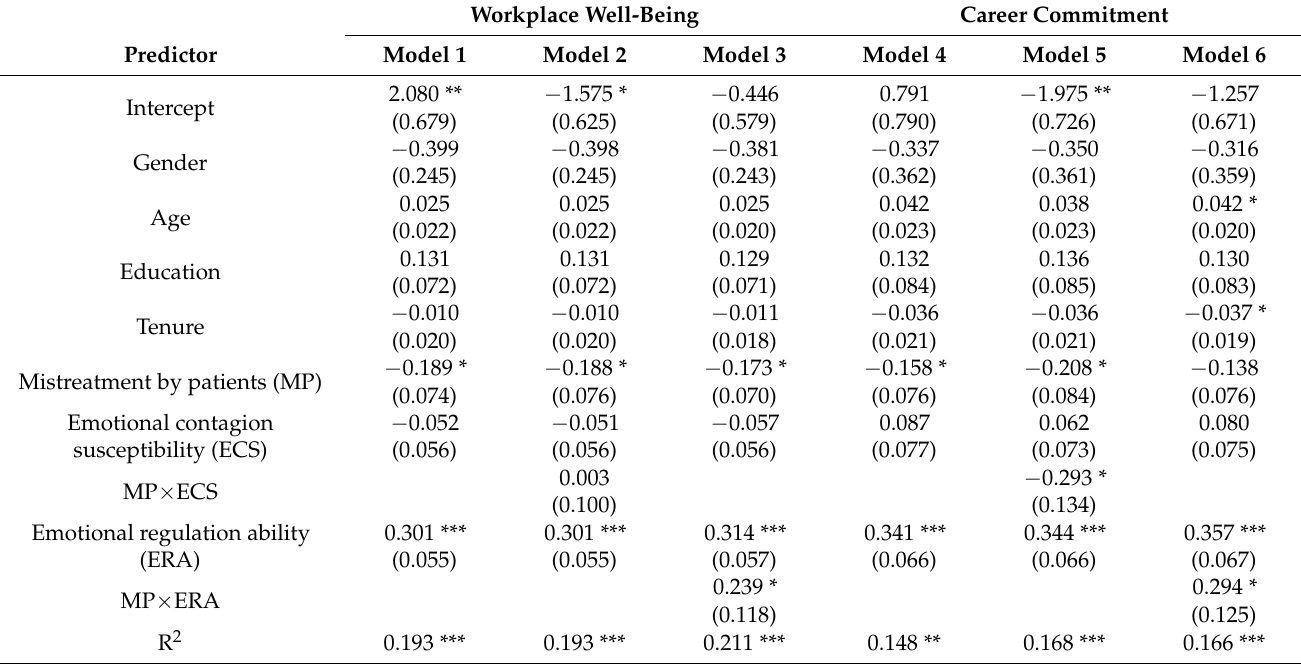
Table 2. Results of hypotheses